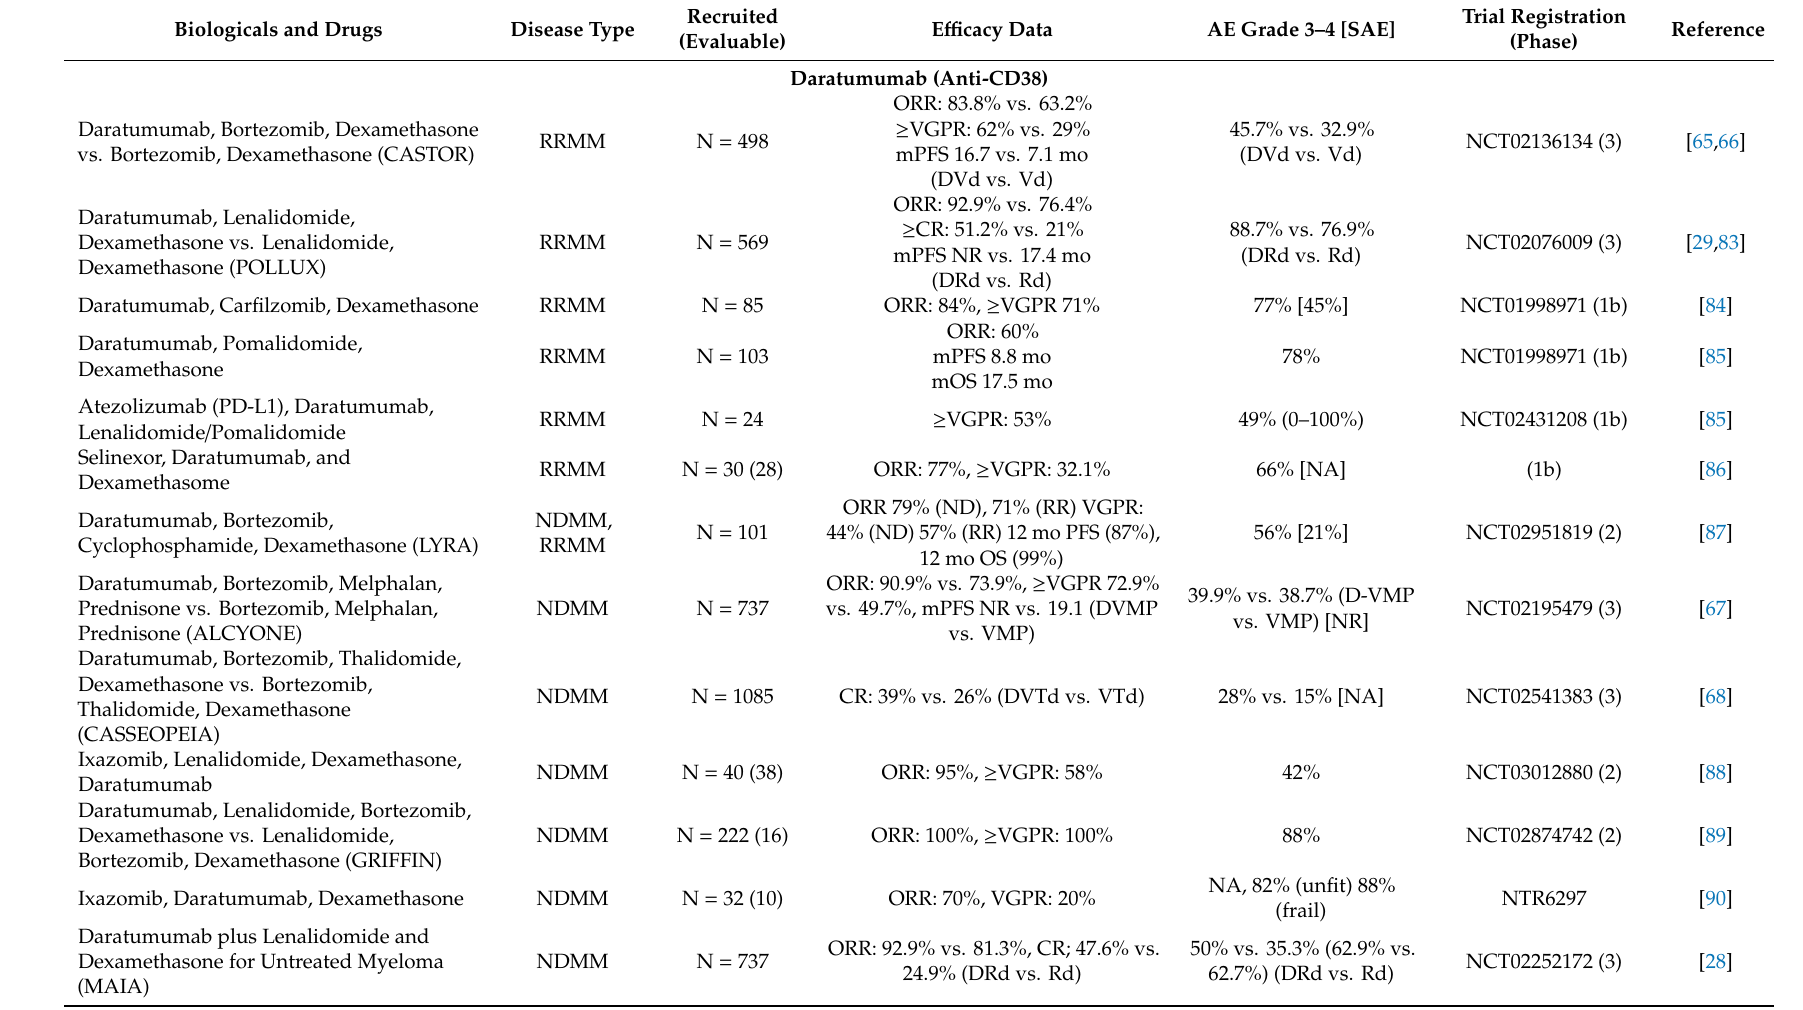
Table 1. Monoclonal